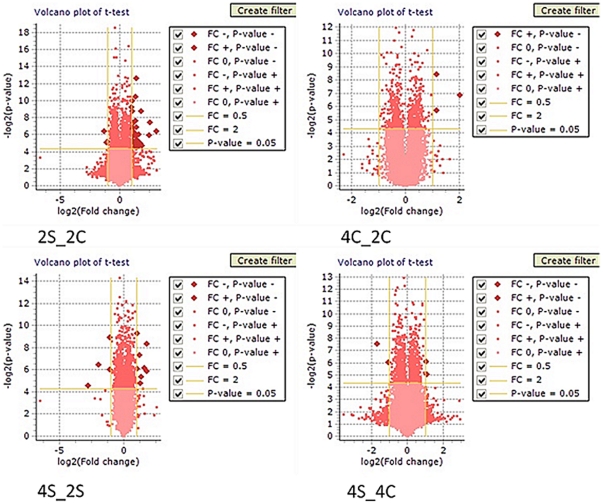
mRNA microarray expression analysis in animals after two weeks of stress (2WSTRESS), recovery from stress (4WSTRESS) and appropriate controls for each time point (2WCONTROL, 4WCONTROL).Genes with a 2-fold difference and a p-value of p<0.05 are shown in logarithmic scale (log2). Genes that were changed are represented as dark-red diamonds, in top-left (down-regulated) and top-right (up-regulated) parts of each figure. 2S_2C – groups of 2WSTRESS vs. 2WCONTROL, 4C_2C – 4WCONTROL vs. 2WCONROL, 4S_2S – 4WSTRESS vs. 2WSTRESS, 4S_2C – 4WSTRESS vs. 2WCONTROL.